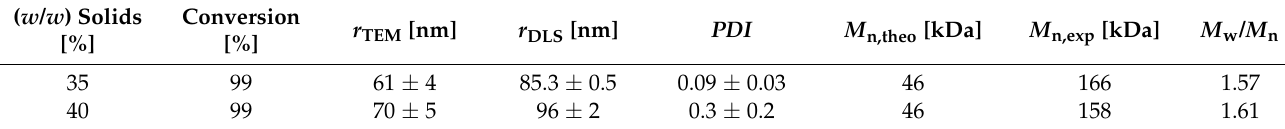
Table 1. Polymerization of PMAA 20 - b -PS 8046 with CTA2 at 80 ◦ C in water and a targeted styrene DP of 360 with a [CTA2]/[ACVA] molar ratio of 5. All reactions were polymerized for 4 h. r TEM represents the number-average radius obtained by TEM and r DLS by DLS. M n,theo represents the theoretical number-average molecular weight of PMAA- b -PS. The dispersity M w / M n was determined my SEC THF + 50 mmol TFA using universal PS calibration. The PMAA-CTA2 macro-CTA was determined with NMR and aqueous SEC using PEO calibration with M n,theo = 8.7 kDa and a M w / M n = 1.17.